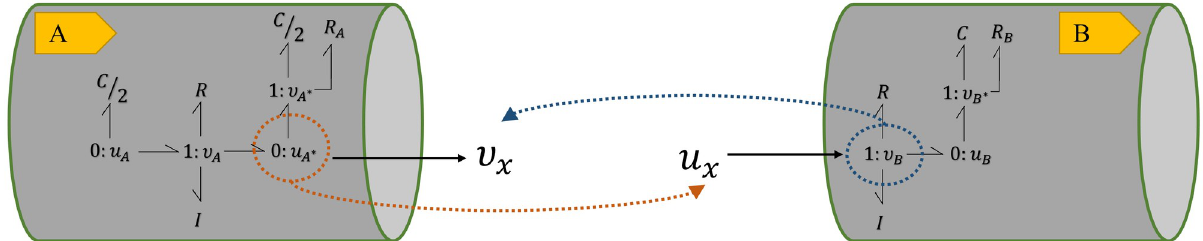
Fig 6. Bond graph modular connection of the vessel models. v in the initial junction of the following module will be mapped to v x at the terminal junction of its preceding module. In the same way, u at the terminal junction of each module will be mapped to u module. v x and u x are auxiliary variables.